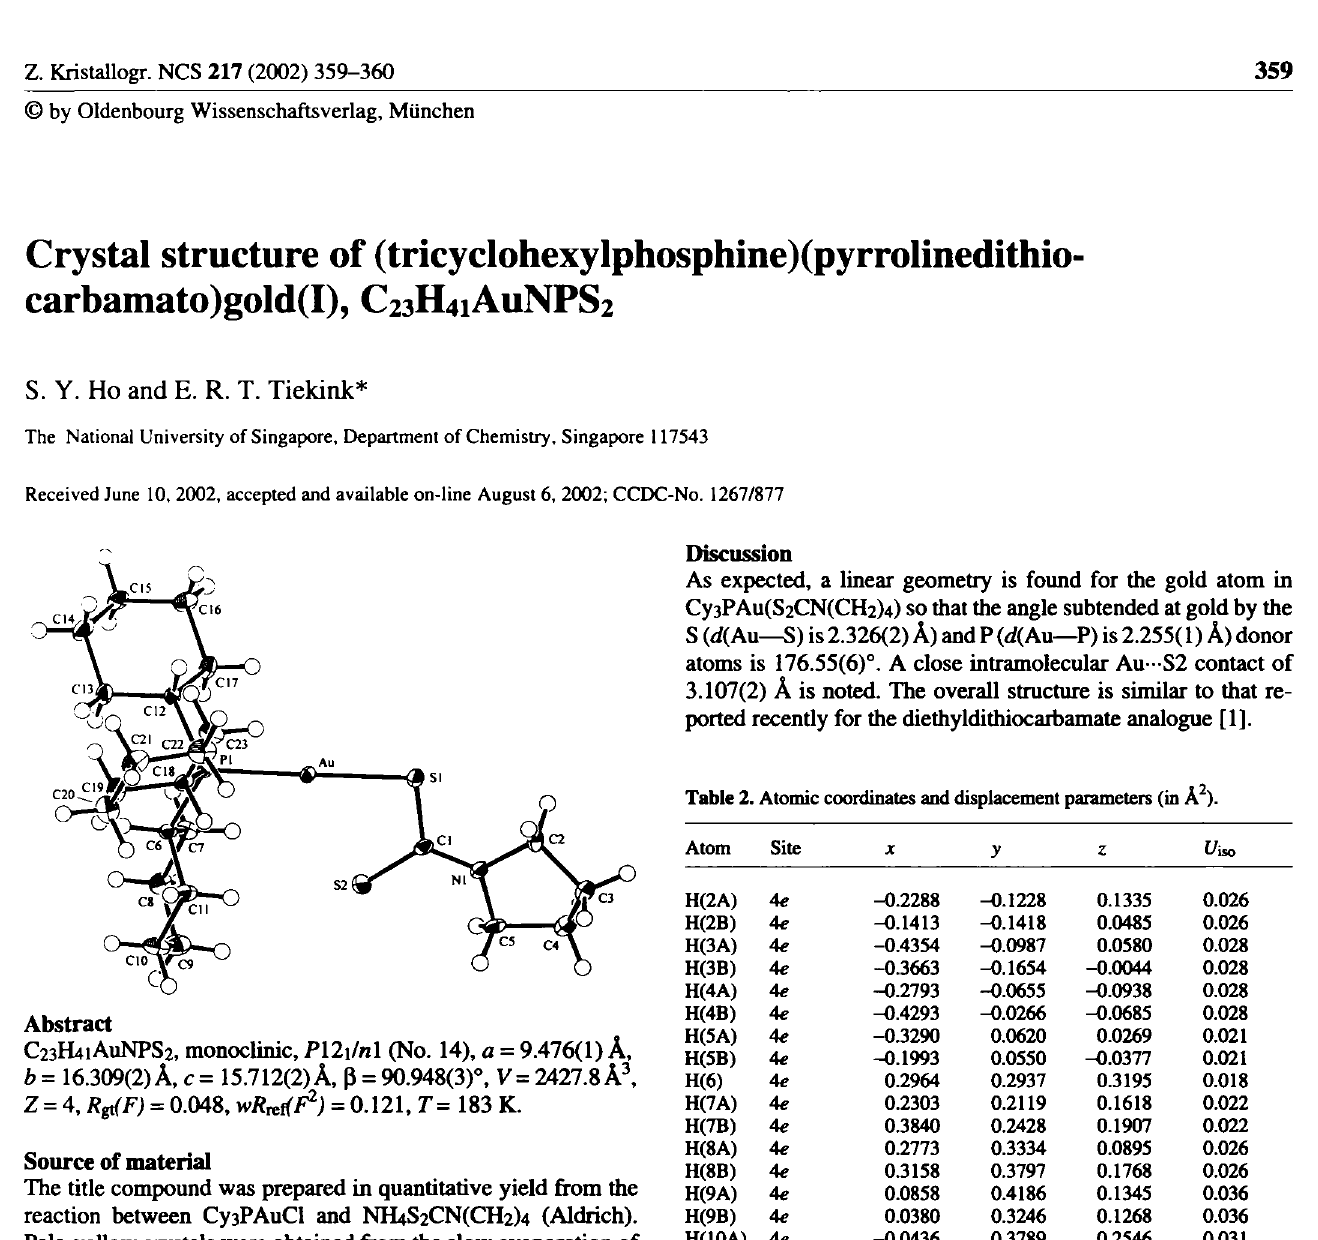
Table 1. Data collection and handling.